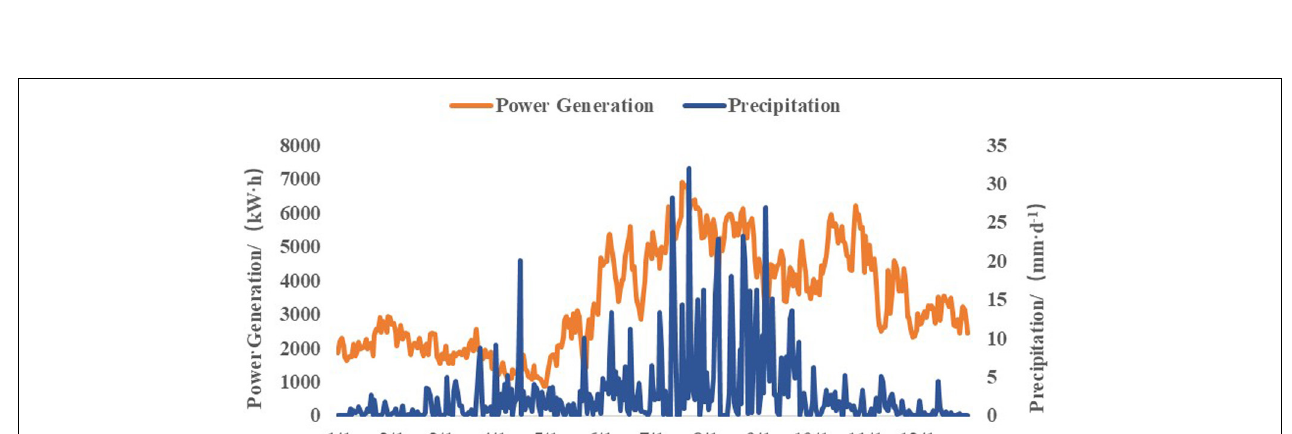
FIGURE 2 | Daily precipitation and power generation of a hydropower station in Dadu River basin.